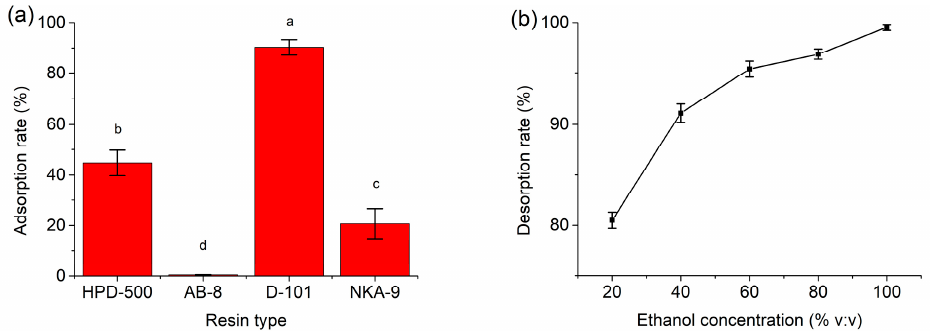
Figure 3. ( a ) The adsorption rate of four different macroporous resins (HPD-500, AB-8, D-101, and NKA-9); ( b ) The desorption rate obtained by different ethanol concentrations. Values followed by different letters (a–d) are significantly different according to Duncan’s test ( p < 0.05).